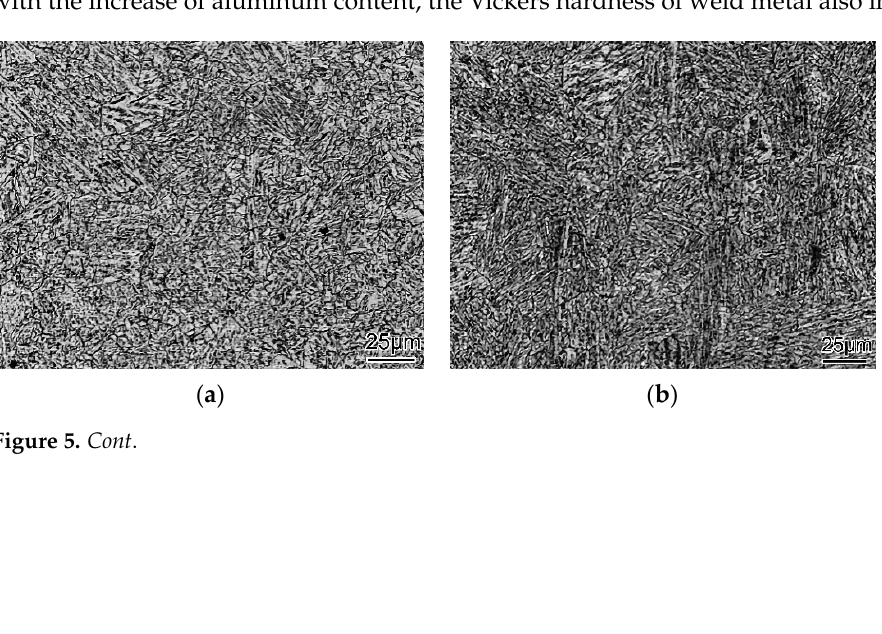
( f ) Figure 5. Effect of Al content on microstructure morphology of weld metal: ( a ) 0% Al; ( b ) 0.21% Al; ( c ) 0.38% Al; ( d ) 0.62% Al; ( e ) 0.81% Al; ( f ) 1.05% Al.